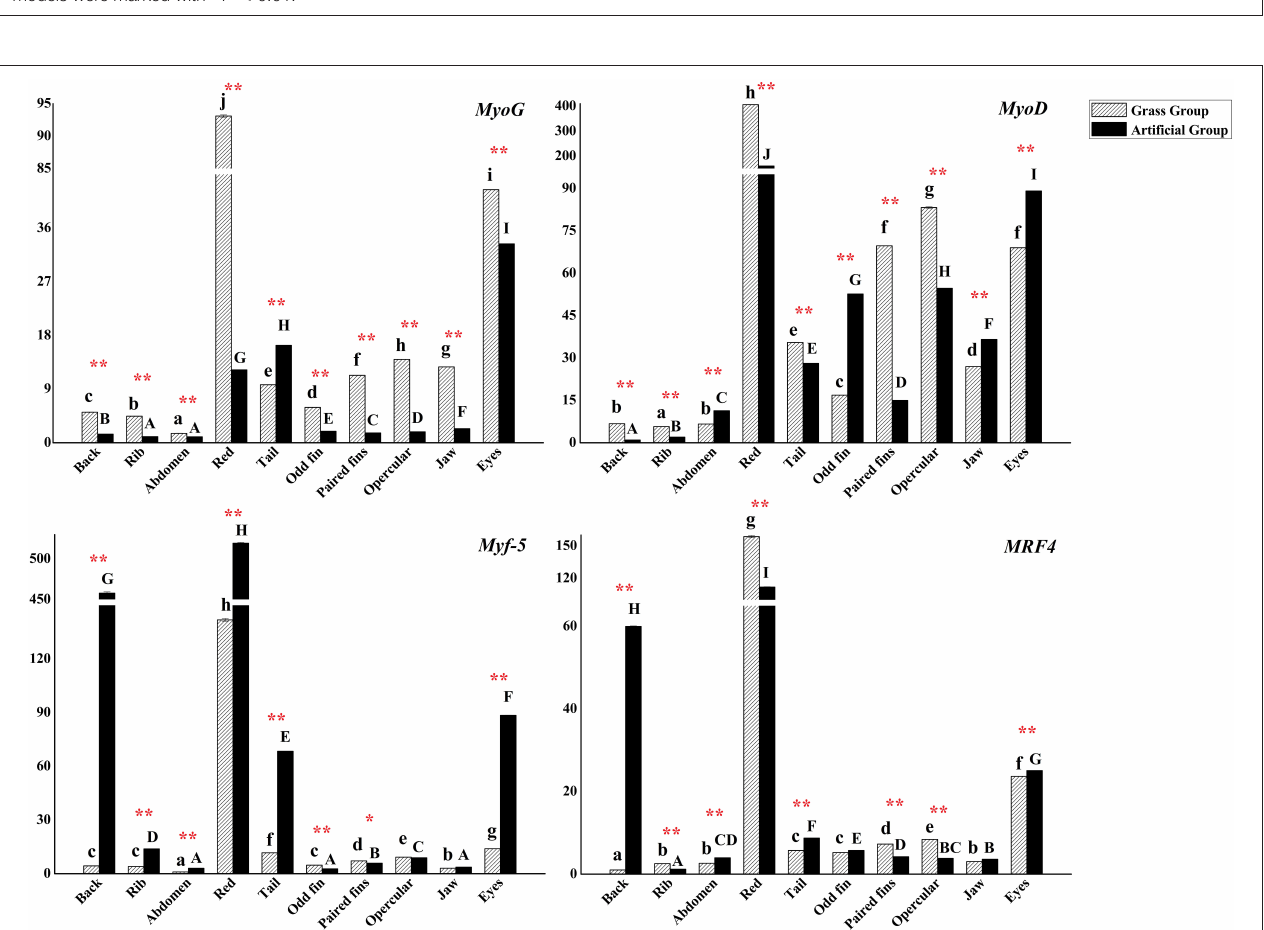
FIGURE 5 | The expression levels of C. idellus MyoG , MyoD , Myf - 5, and MRF4 in 10 positional muscle tissues . The expression levels of C. idellus MyoG , MyoD , Myf - 5, and MRF4 in back, rib, abdomen, red, tail, odd fin, paired fins, opercular, jaw, and eyes muscle samples, which collected respectively from the two culture model C. idellus . The expressions of genes in grass feeding C. idellus (dense slash filling) and artificial feeds feeding C. idellus (black filling). The β -actin was used as an internal control to calibrate the cDNA template for all the samples. Vertical bars represent the mean SE. Different letters mean significantly different ( P < 0.05) in the ± same model, lowercase letters used in grass feed group, capital letters used in artificial feed group. Meanwhile, the star bars also indicate the significance between the two culture models in red color, *means significant ( P < 0.05), **means greatly significant ( P < 0.01).